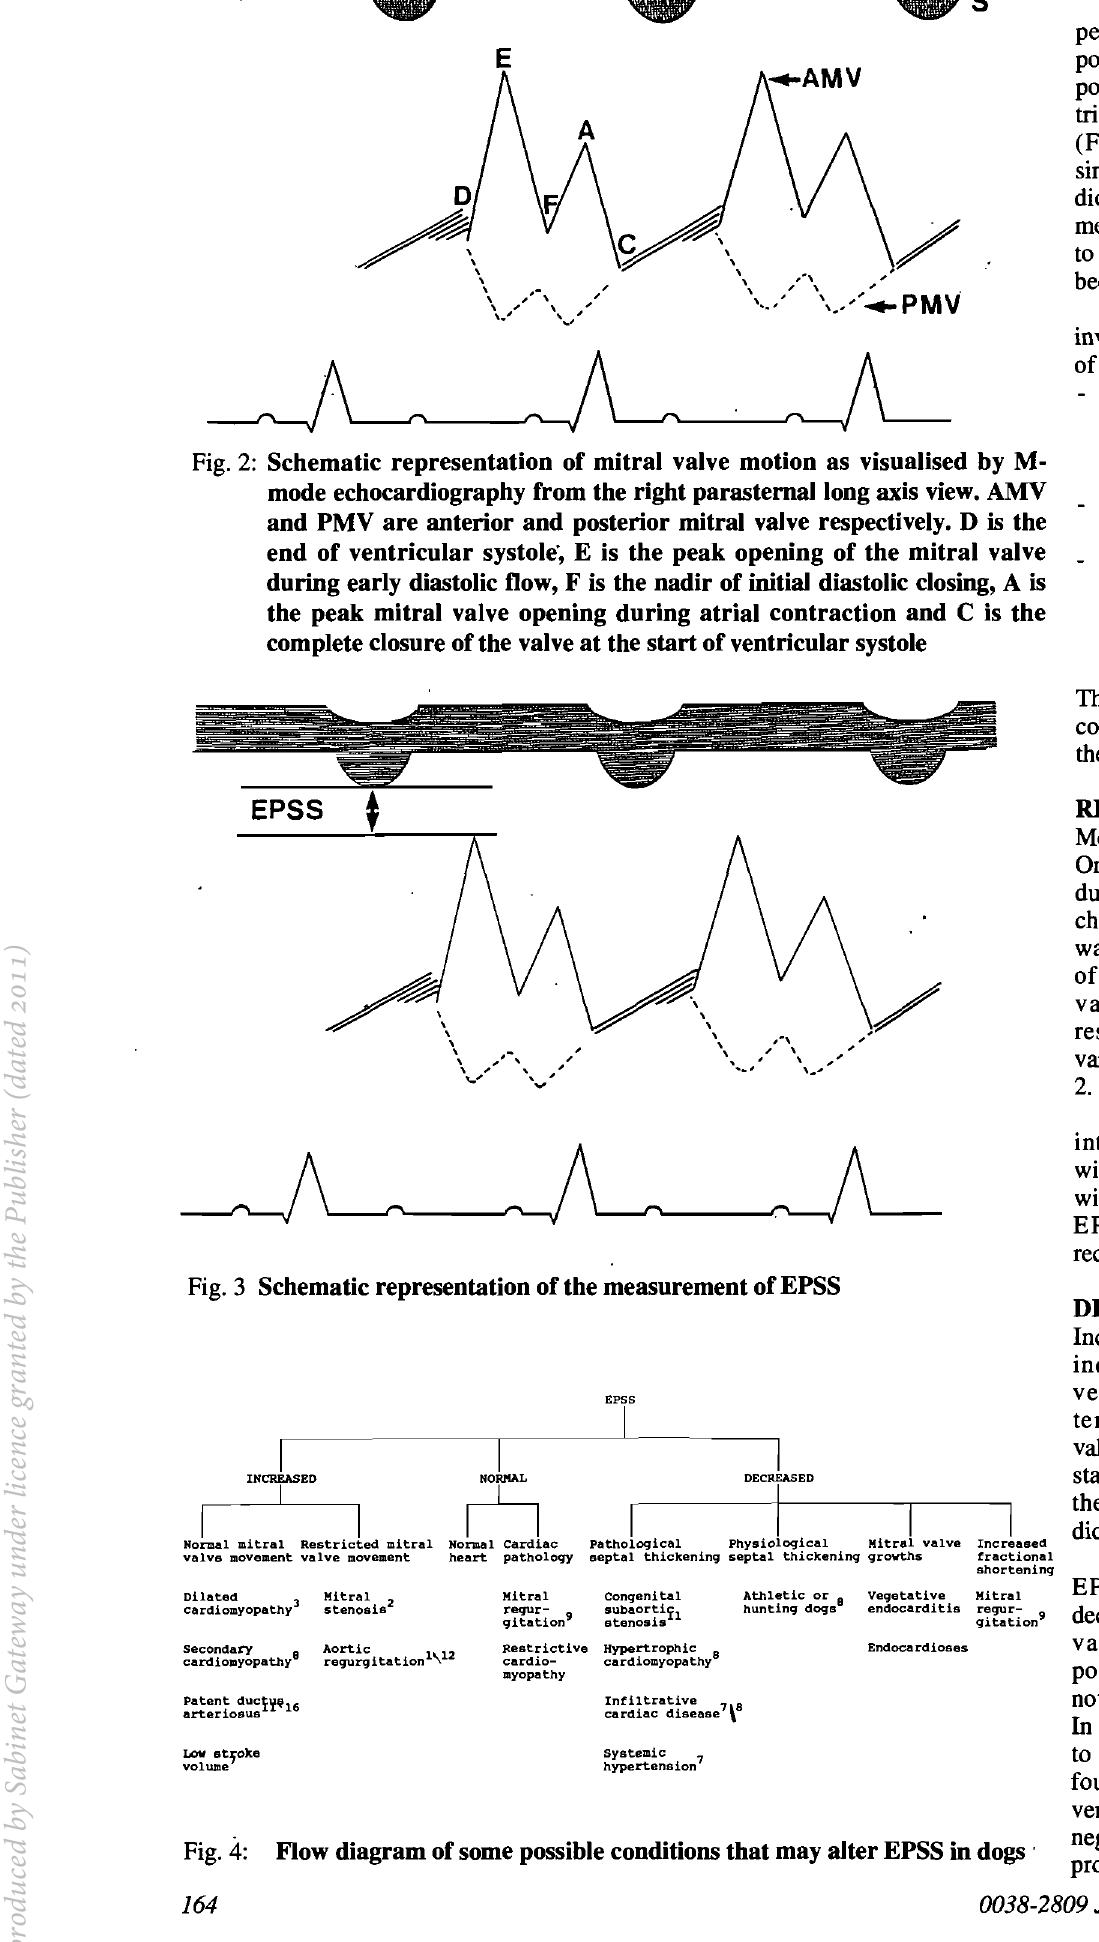
Fig. 4: Flow diagram of some possible conditions that may aJter EPSS in dogs